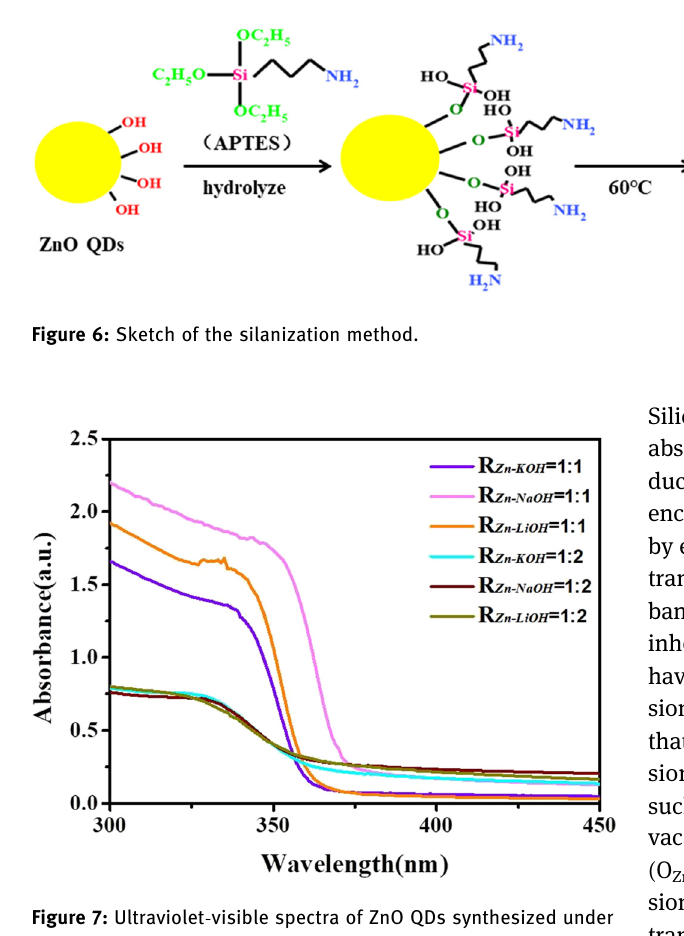
( 370 nm ) and a strong and broad yellow emission peak ( 530 nm ) . It is well known that the intensity of emission depends on both size and surface properties of the dots.